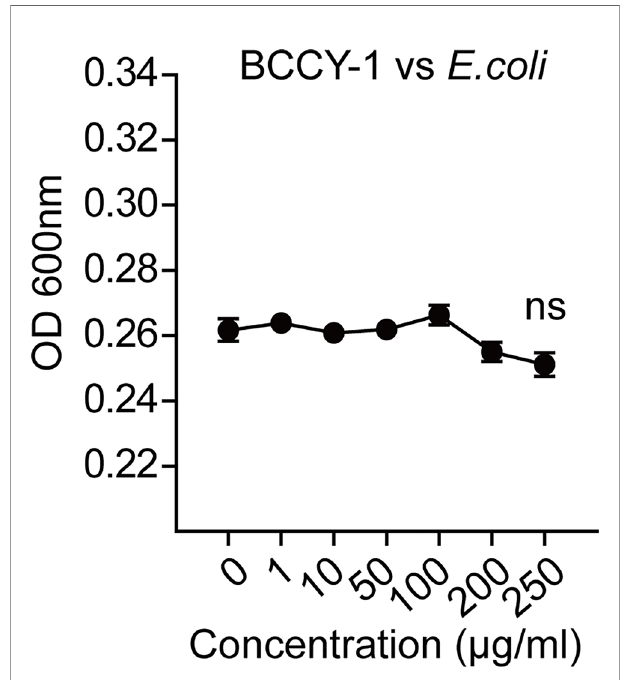
FIGURE 6 | BCCY-1 lacks directly antimicrobial effect. The direct effect of BCCY-1 on the growth of E.coli. ns p